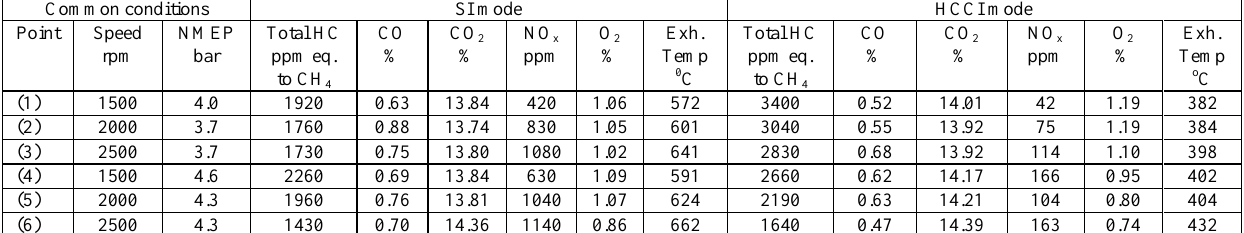
Table 7. Operation conditions and parameters of the V6 engine in SI and HCCI modes (all for λ = 1.0). Normalized emission values and fuel con- Common